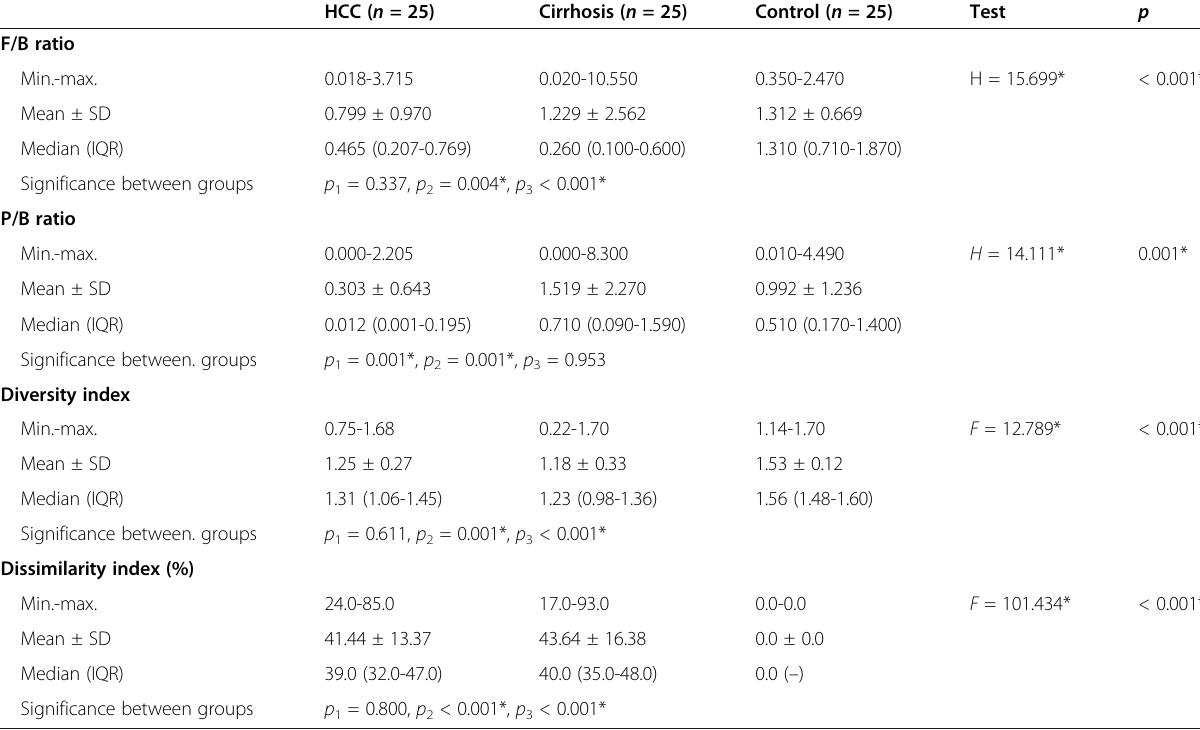
Table 2 Comparison between the three studied groups according to Firmicutes to Bacteroidetes (F/B) ratio, Prevotella to Bacteroides (P/B) ratio, diversity index, and dissimilarity index